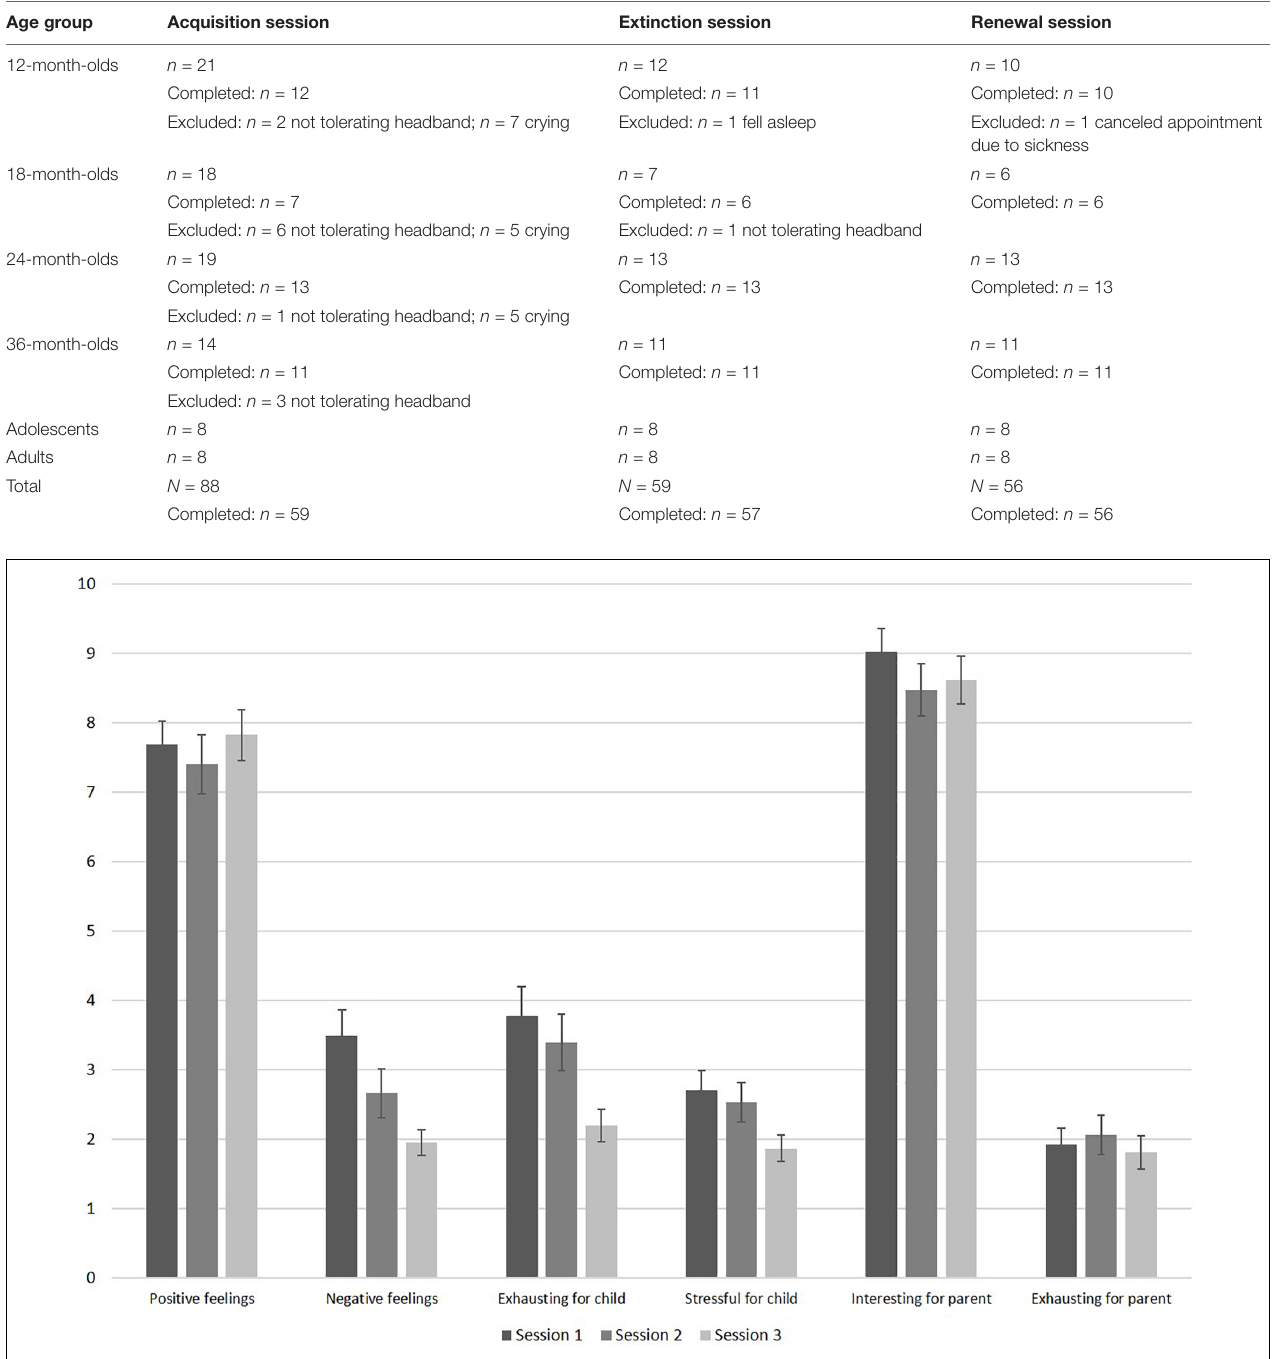
FIGURE 3 | Results of the feasibility questionnaire filled out by parents after each session (sample sizes: positive feelings: n = 34; negative feelings: n = 35; all others: n = 36). The scale ranges from 10 (very high) to 0 (very low). Error bars are SE of M.